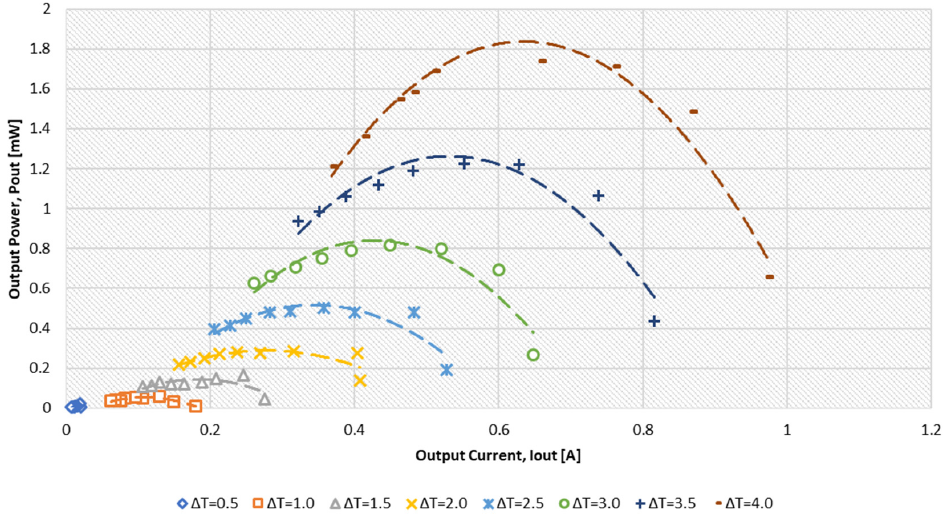
Figure 9. Thermal EHC Output Power–Output Current curve at 3.3 V.